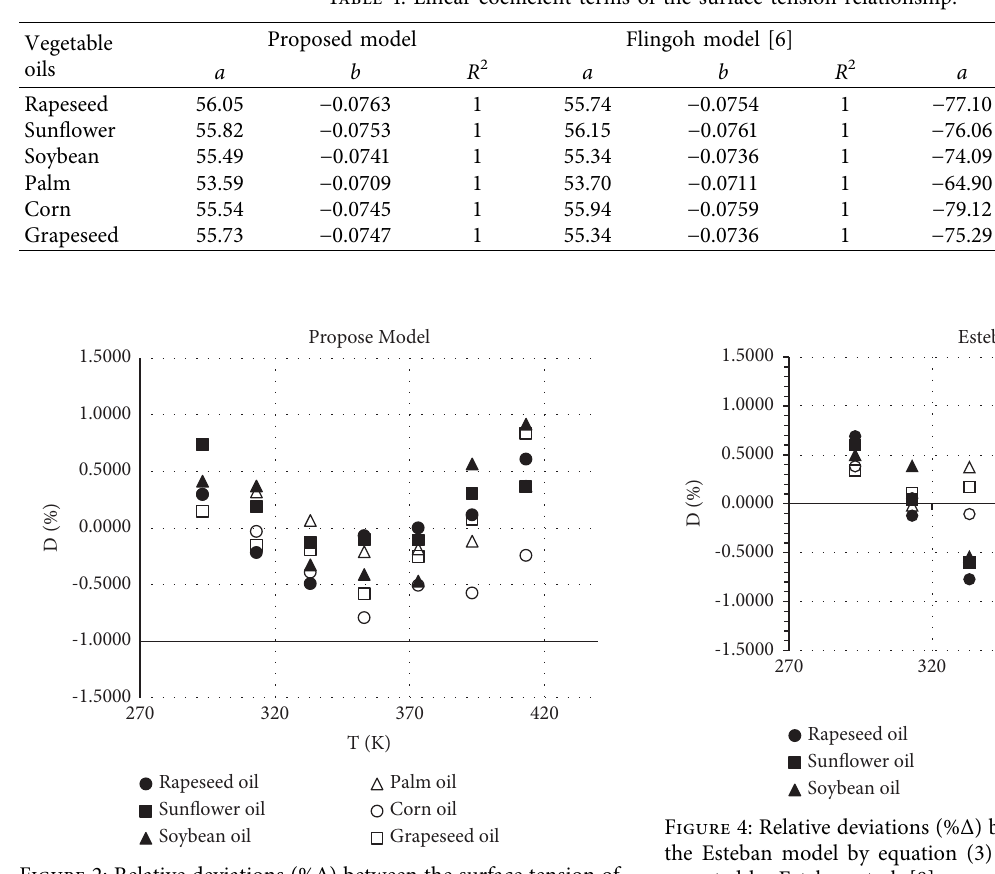
Figure 2: Relative deviations (% Δ ) between the surface tension of the proposed model by equation (23) and the experimental values reported by Esteban et al. [8].